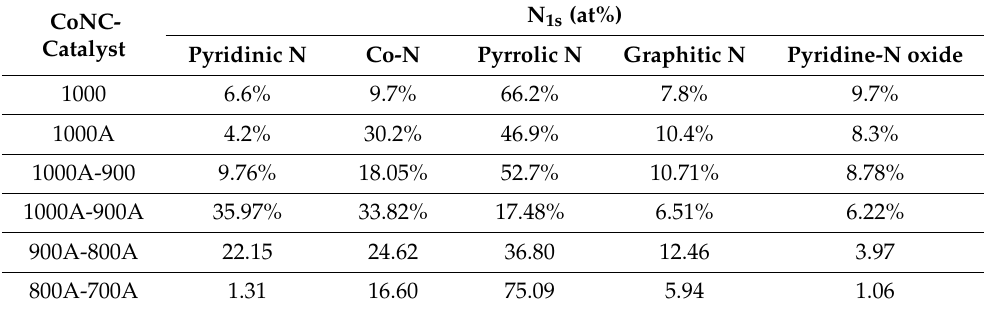
Table 1. Atomic ratios of the different N species in Co-N-C-catalysts, as determined by XPS analysis. N 1s (at%) CoNC- Catalyst Pyridinic N Co-N Pyrrolic N Graphitic N Pyridine-N